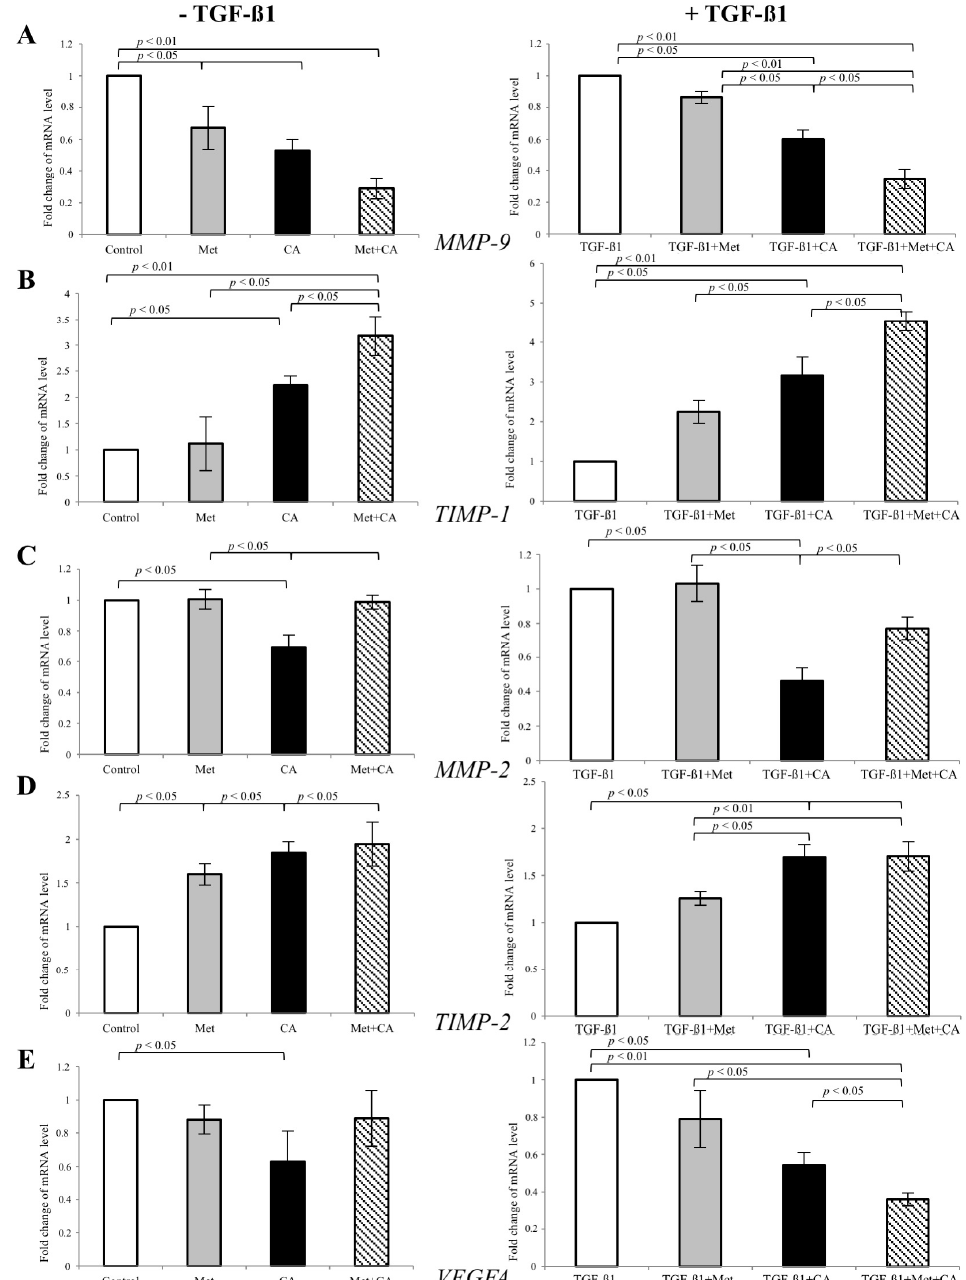
Figure 6. The effect of Caffeic Acid (CA) and Metformin (Met) on the expression of gelatinases MMP- 9 ( A ) and MMP- 2 ( C ) and tissue inhibitors TIMP-1 ( B ) and TIMP-2 ( D ) in C4-I cells. The cells were incubated with addition of tested compounds (CA at 100 μ M and/or Met at 10 mM) and with/without 10 ng/mL TGF- β 1 for 48 h. Then mRNA was isolated and purified for Real-time PCR examination. In TGF- β 1-stimulated cells, CA and CA/Met caused decrease in mRNA level for MMP-9 ( p < 0.01 vs. control) with concomitant increase of mRNA for its specific tissue inhibitor TIMP-1 ( p < 0.01 vs. control). The incubation of TGF- β 1-treated cells with CA/Met attenuated the expression of angiogenic molecule VEGFA ( E ). Data shown here were repeated three times with similar results and presented as mean values ± SD ( B ).